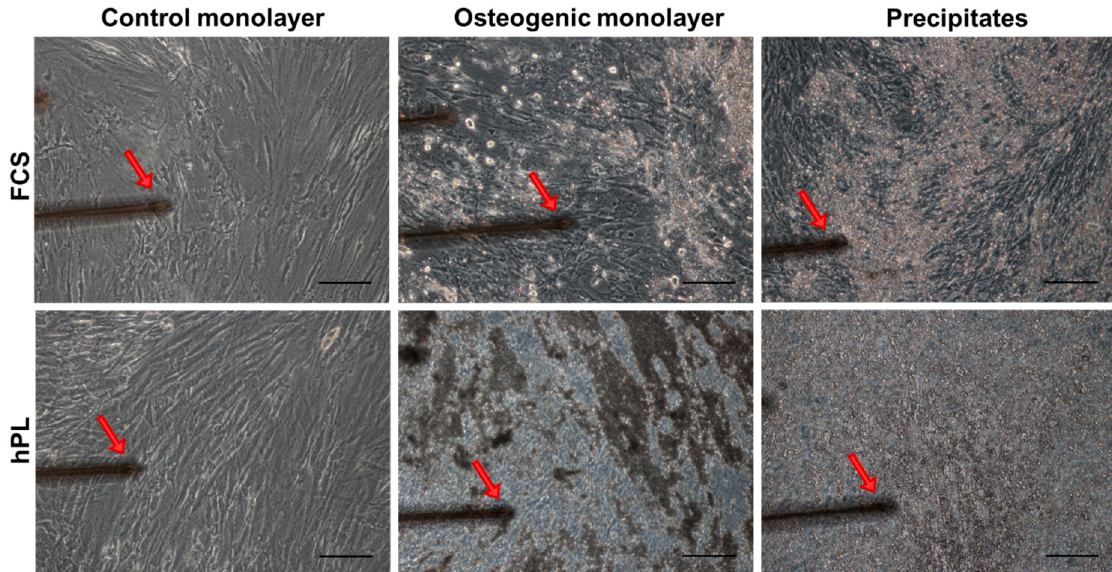
Figure 8. Representative microscopic images indicating the regions of interest subjected to elasticity measurements. Microscopic pictures of AFM measured JPCs—control monolayers (left pictures), osteogenic induced JPCs (middle) and calcium phosphate precipitates (right pictures) formed under hPL and FCS culturing conditions, respectively. Red arrows depict the position of the cantilever for elasticity measurements of non-mineralized regions in untreated (left) and osteogenic monolayers (middle, without precipitates) and of calcium phosphate precipitates. Images were acquired with the inverted AxioObserver D1 light microscope attached to the AFM system at a 10 × magnification. Scale bar (black) represents 30 µm. Abbreviations: AFM—atomic force microscopy, JPCs—jaw periosteum derived progenitor cells, FCS—fetal calf serum, hPL—human platelet